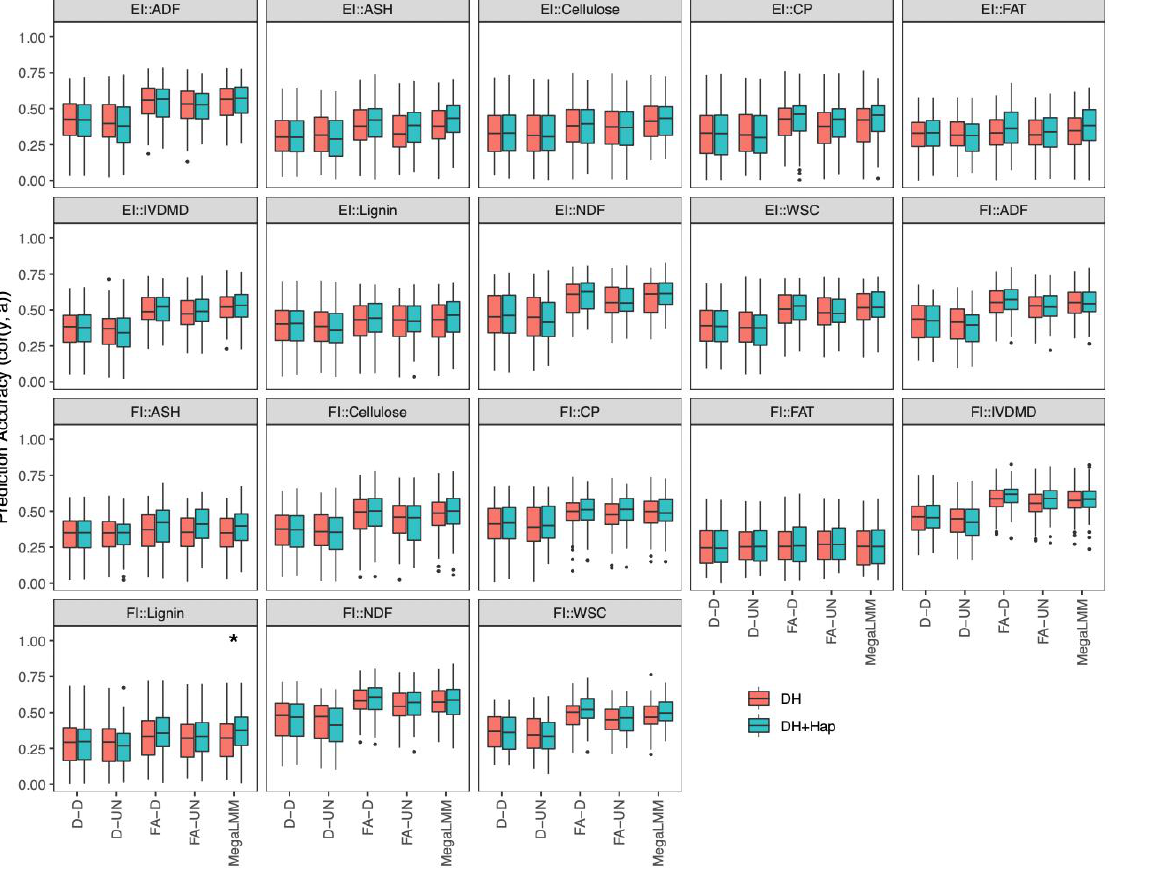
Figure 6. Distribution of prediction accuracies of the 18 stalk quality traits in the DH population across 20 resampling runs estimated by multi-trait models in multi-environment trials. For each multi-trait model, the uppercase letters before and after the hyphen represent genetic and residual covariance structures: D = diagonal, UN = unstructured and FA = factor-analytic. The corrected resampled t -test test was applied to test difference in prediction accuracy between DH-population- based (DH-based) and DH and haploid populations-based (DH + Hap-based) genomic predictions across environments. Significance levels are indicated above each box, with * significant at p <